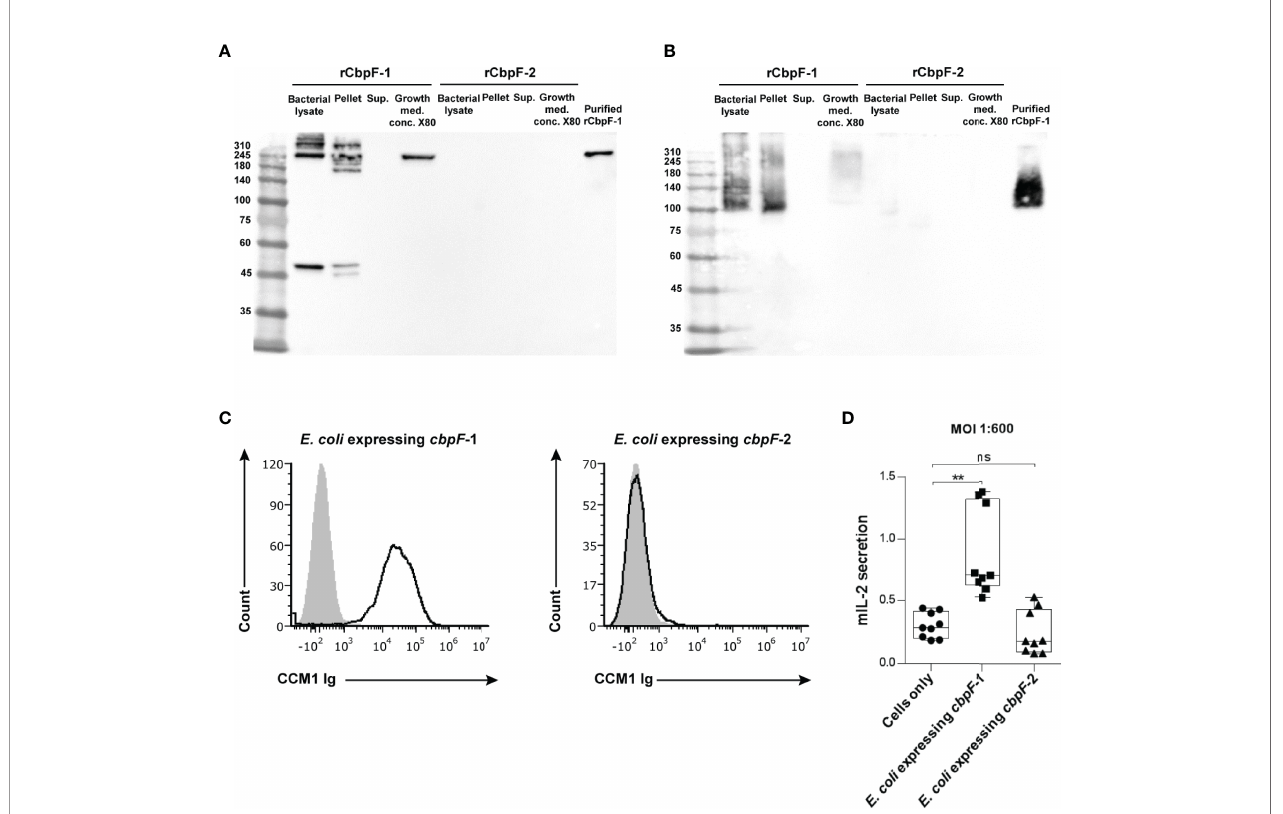
FIGURE 2 | Recombinant E. coli expressing CbpF-1 binds CEACAM1. Whole bacterial lysate; Pellet and Supernatant (Sup.) fractions after lysis; growth medium concentrated X80 (Growth med. conc. X80) of E. coli C43 expressing cbpF -1 or cbpF -2; and Ni-NTA -puri fi ed rCbpF1 were subjected to denaturing (A) , and native (B) 7.5% SDS-PAGE followed by far western analysis using CEACAM1-Ig (see materials and methods). Molecular weights are indicated on the left. (C) FITC-labeled E. coli expressing cbpF -1 or E. coli expressing cbpF -2 were stained with 2 m g of human CEACAM1-Ig. Human B lymphoblastoid cell line 721.221 cells were used as carrier cells. Filled grey histograms represent staining with secondary antibody only. Presented results represents one of two independent repeats. (D) CEACAM1-reporter BW cells were incubated with E. coli expressing cbp F-1 or cbp F-2 at a ratio of 1:600. Mouse IL-2 (mIL-2) in the supernatants 48 hours later was determined by ELISA. Boxplot whiskers represent extrema, box bounds represent upper and lower quartiles, and center-line represents the median value of nine observations. n.s., non- signi fi cant, ** p =0.0033 two-tail, as determined by the Dunn post-hoc multiple-comparisons procedure following the Kruskal-Wallis test (GraphPad Prism